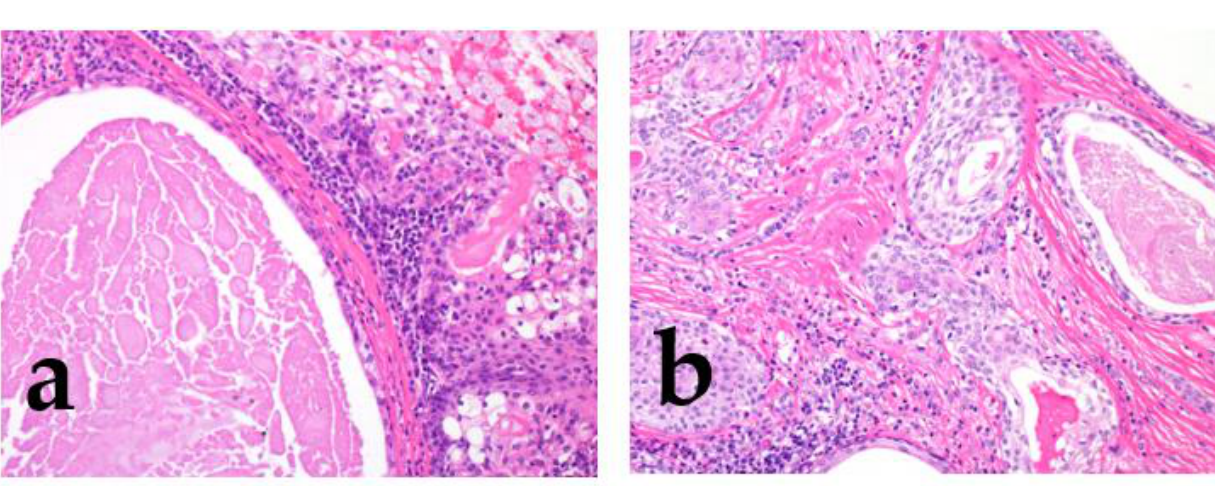
Figure 4. The morphological features of low/intermediate mucoepidermoid carcinoma (MEC). The tumor forms cystic ( a ; low grade) and solid growth patterns ( b ; intermediate). In both cases, tumor cell atypia is mild, but the intermediate category shows slightly different nuclear sizes with mitosis.